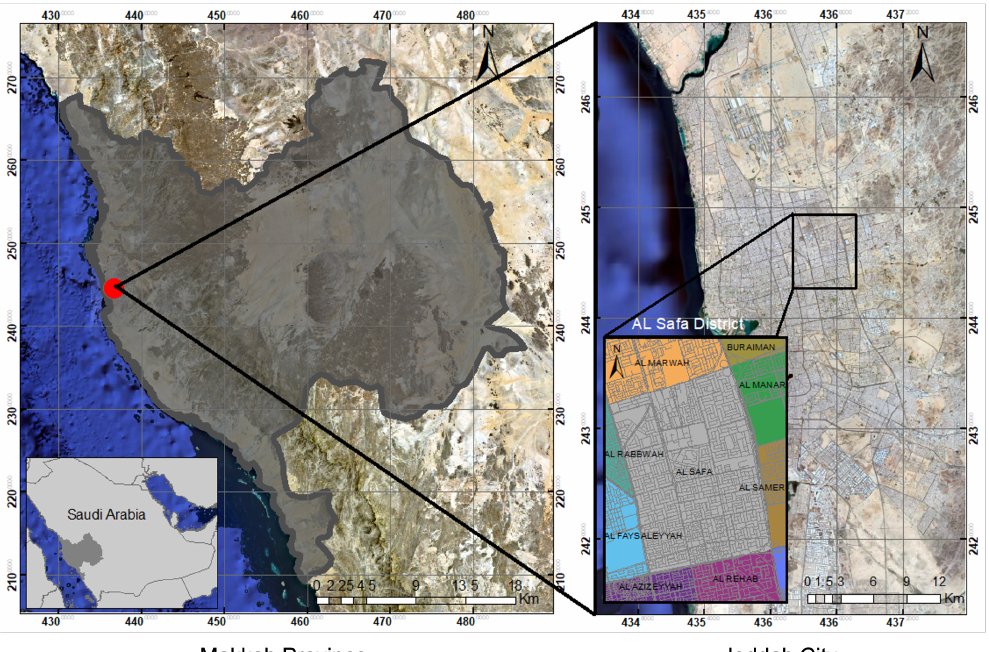
Figure 2. Location map of the city of